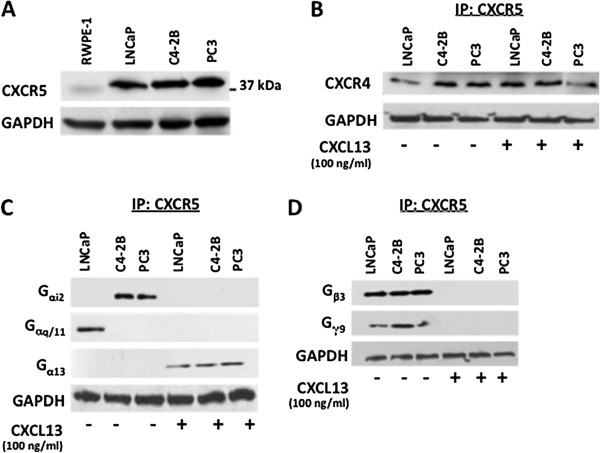
Expression of CXCR4, CXCR5 and associated G proteins in PCa cell lines. (A) Equal protein amounts (50 μg) from RWPE-1, LNCaP, C4-2B, and PC3 cell lysates were resolved by SDS-PAGE and the expression of CXCR5 (37 kDa) was determined by immunoblot. (B) Western blot analysis of CXCR4 expression with and without CXCL13 treatment. (C) & (D) Cell lines were treated with or without CXCL13 and lysed. CXCR5 was immunoprecipitated (IP) to pull down associated proteins from total cell lysates. The IP cell lysates were resolved by SDS-PAGE and the expression of (C) Gαi1, Gαi2, Gαi3, Gαs, Gαq/11, Gα12, Gα13 (D) Gβ1, Gβ2, Gβ3, Gβ4, and Gγ5, Gγ7, Gγ9, Gγ10 were examined by immunoblot. The blots in panel C and D were stripped each time and re-probed to stain different Gα, Gβ, and Gγ protein subunits. In all the experiments, GAPDH served as loading control. All experiments were repeated three times with unvarying results.